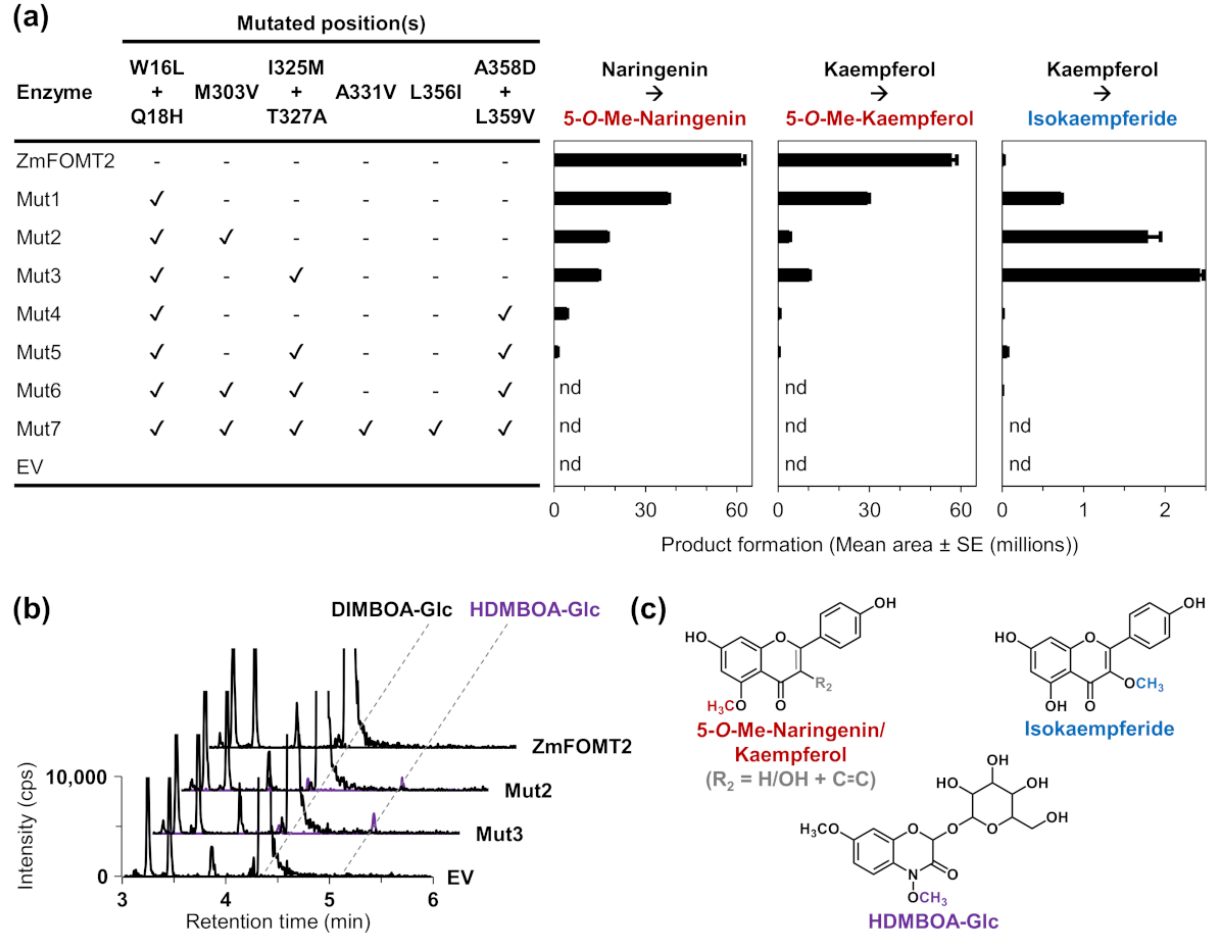
Figure 4. Enzymatic activity of ZmFOMT2 mutants with flavonoids and DIMBOA-Glc. The purified recombinant enzymes as well as an empty vector control (EV) were incubated with the substrates naringenin or kaempferol ( a ) and DIMBOA-Glc ( b ) in the presence of the cosubstrate SAM. Reaction products were analyzed by LC–MS/MS. Product formation is shown in bar charts (mean area ± SE ( n = 3)) or as chromatograms of specific MRM transitions (see Methods section). In contrast to the assays shown in panel ( a ), for the assays in panel ( b ), a 2.5-fold greater amount of purified recombinant enzyme (~2 µ g/assay), a 2.5-fold greater amount of substrate (50 µ M), and a 5-fold greater amount of cosubstrate were used. ( c ) Structures of the enzymatic products with the attached methyl groups are highlighted in red (5- O -methylnaringenin and 5- O -methylkaempferol), blue (isokaempferide), and purple (HDMBOA-Glc). Abbreviations: Me—methyl; nd—not detected; cps—counts per